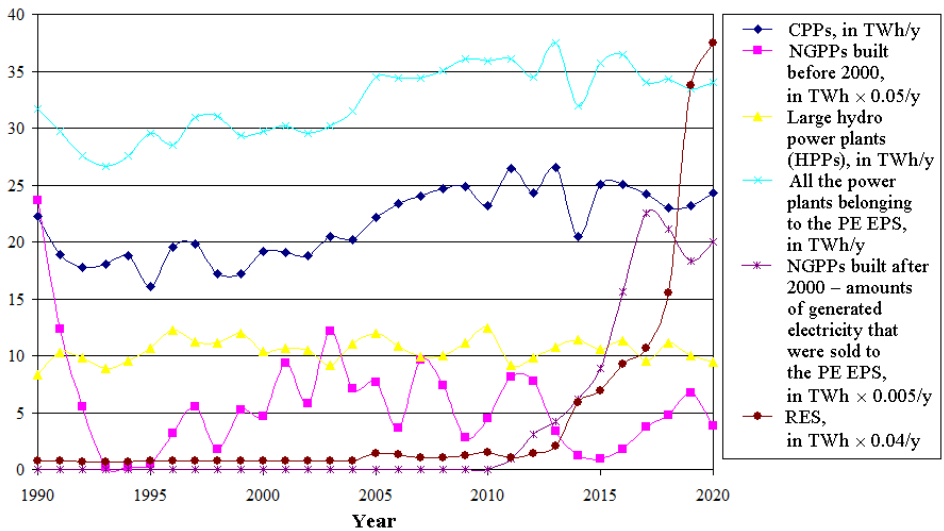
Figure 1. Annual electricity generation in Serbia from various power plants [54 – 57].